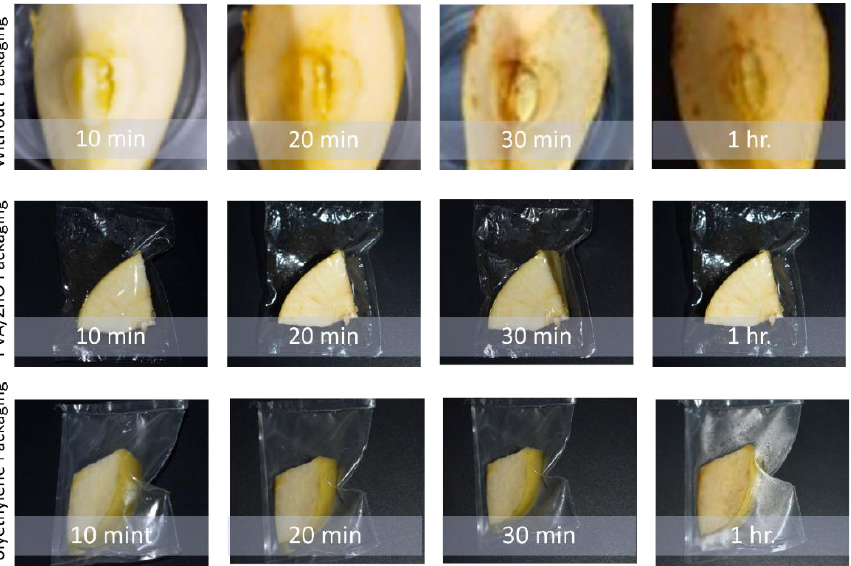
Figure 13. Degradation test apple pieces packaged in PVA/ZnO films and commercial polyethylene packagings.